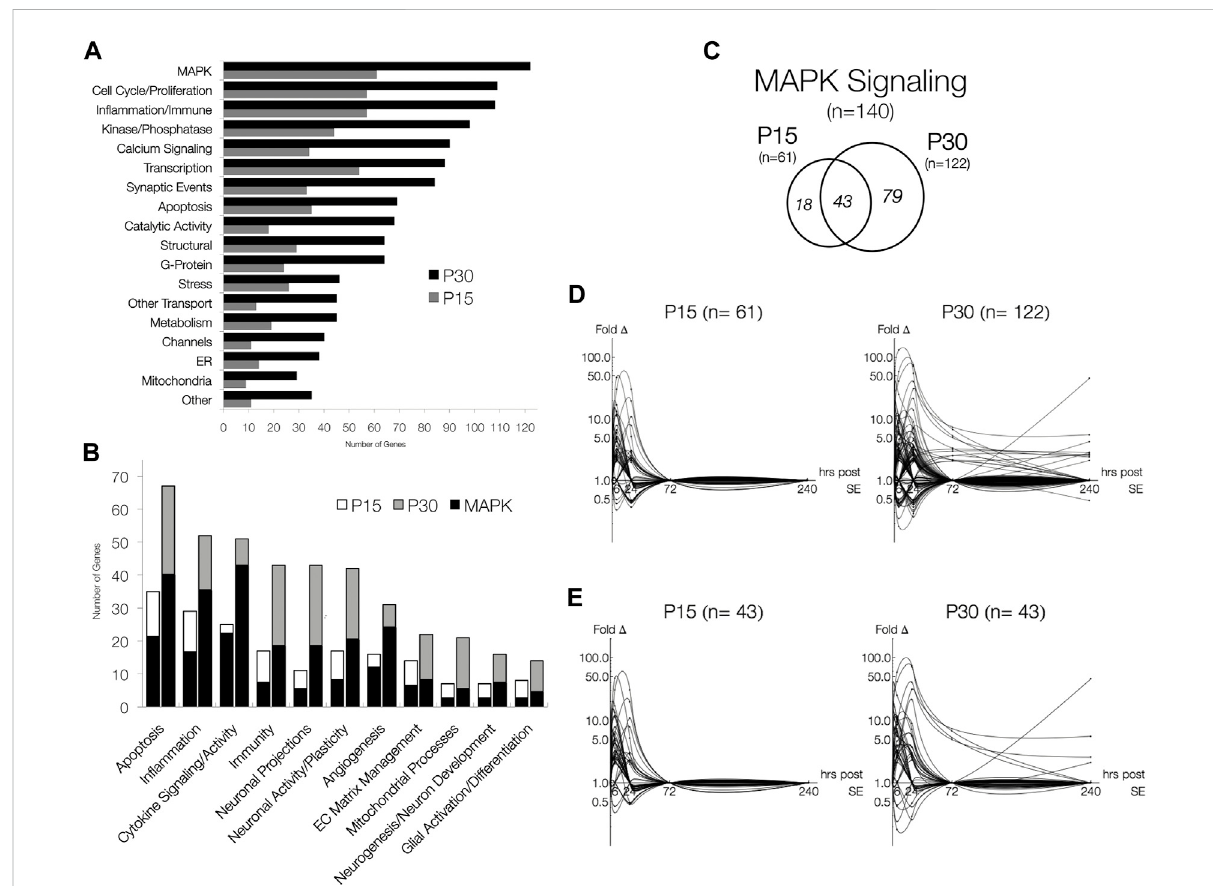
FIGURE 5 Functional Distribution of Differentially Expressed Genes and MAPK Signaling pathway, the most abundant functional groups. (A) Genes involvedinprocessesassociatedwiththelatentperiodandMAPKsignaling.Geneswerecategorizedinagreementwithdatabases. (B) Thenumberof genesassociated with MAPK signaling inP15 andP30animals across all time points. Signi fi cantly expressedgenesare more numerousinP30than in P15, but relative MAPK co-categorization is comparable. MAPK overlaps most with cytokine signaling/activity (24/25, P15; 46/51, P30) and least with mitochondrial processes (3/7, P15; 6/21, P30) and glial activation/differentiation (3/8, P15; 5/14, P30). (C) Venn Diagrams of differentially expressed genes belonging to MAPK Signaling (fold change > 2, p < 0.05, q < 0.05). While majority (70.5%) of genes in P15 are also expressed in P30, most (64.8%) genes are only expressedinP30. (D) Log-linearplotsof differential gene expression (fold change) of MAPK genes 1 – 240 hafter KA-SE. Data points are indicated by black circles. Lines, each representing a single gene, were fi tted using second order interpolation for ease of visualization. (E) Log-linear plots of differential gene expression (fold change) of common MAPK genes between P15 and P30.